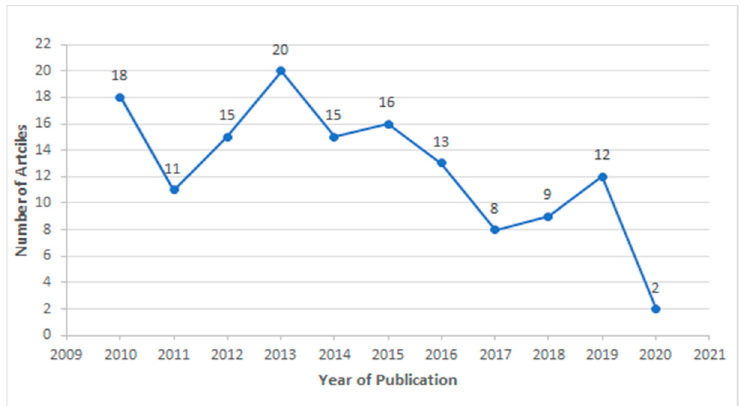
Figure 3. Trends in the number of